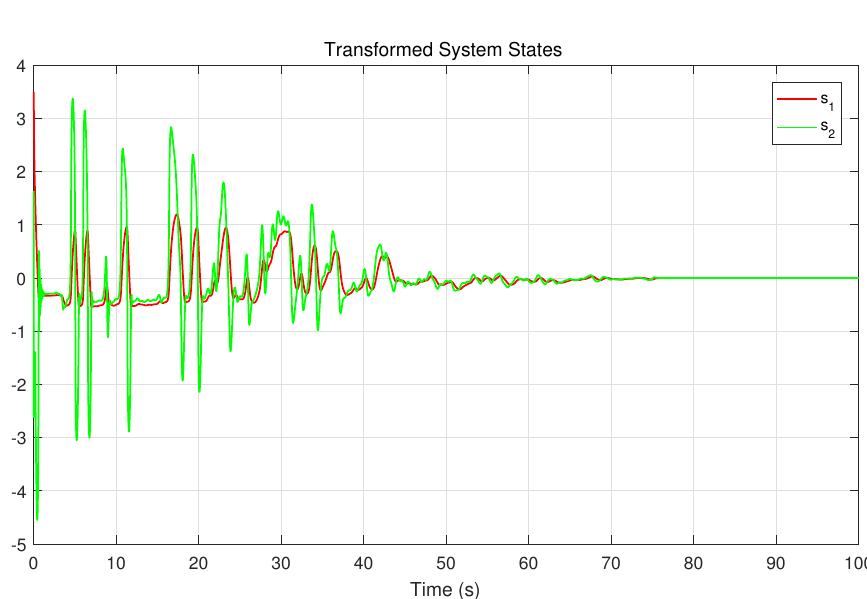
Figure 4. Evolution of the critic estimates for player 2.